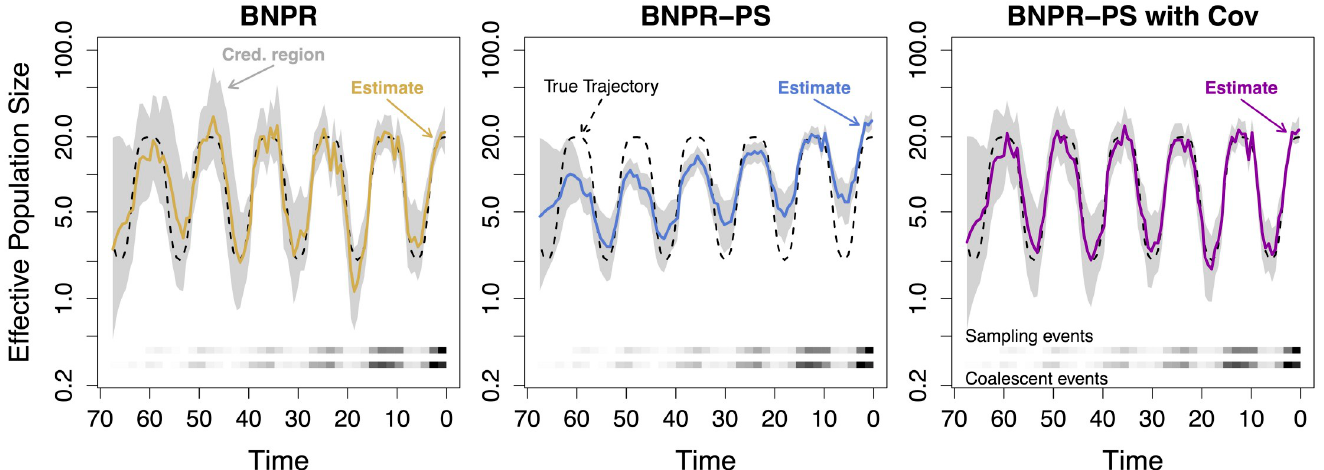
Fig 3. Effective population size reconstruction for BNPR, BNPR-PS, and BNPR-PS with simple covariates. The dotted black line represents the true effective population trajectory. The solid colored line represents the marginal posterior median effective population trajectory inferred by BNPR (yellow), BNPR-PS (blue), and BNPR-PS with simple covariates (purple), and the gray region represents the corresponding pointwise 95% credible intervals for the effective population trajectory. The log sampling intensity was 1.557 + γ ( t ) − 0.025 t .